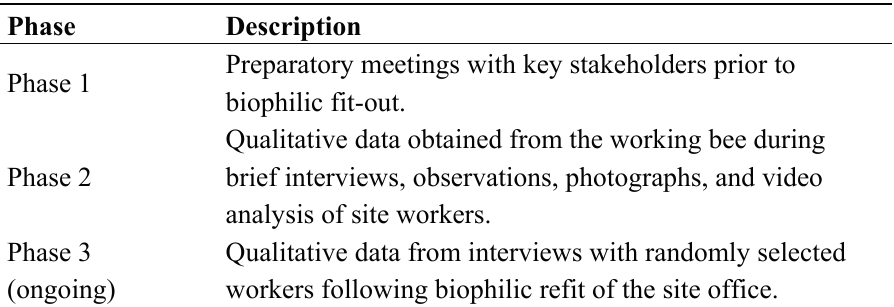
Table 2. Data collection up to May